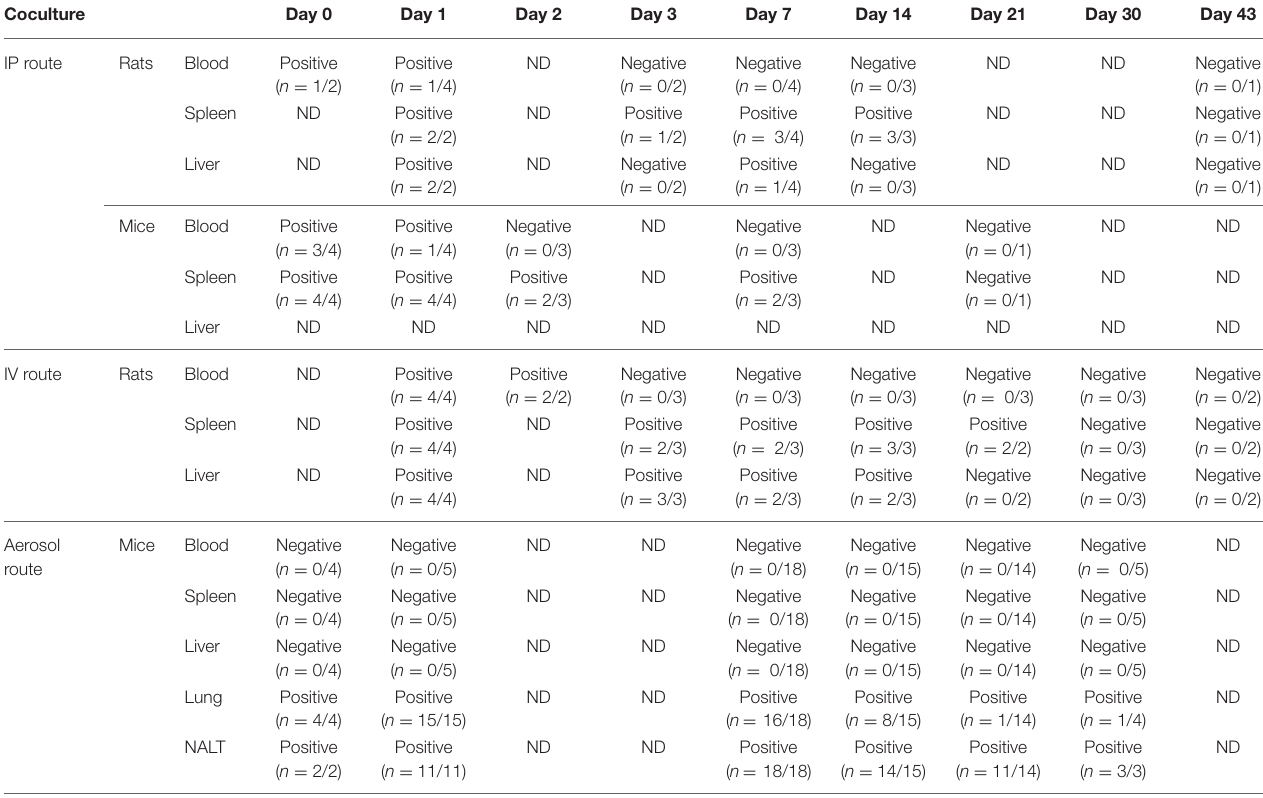
TABLE 2 | Summary of results obtained by amoebal co culture of blood and organs of rats and mice inoculated with Marseillevirus. Coculture